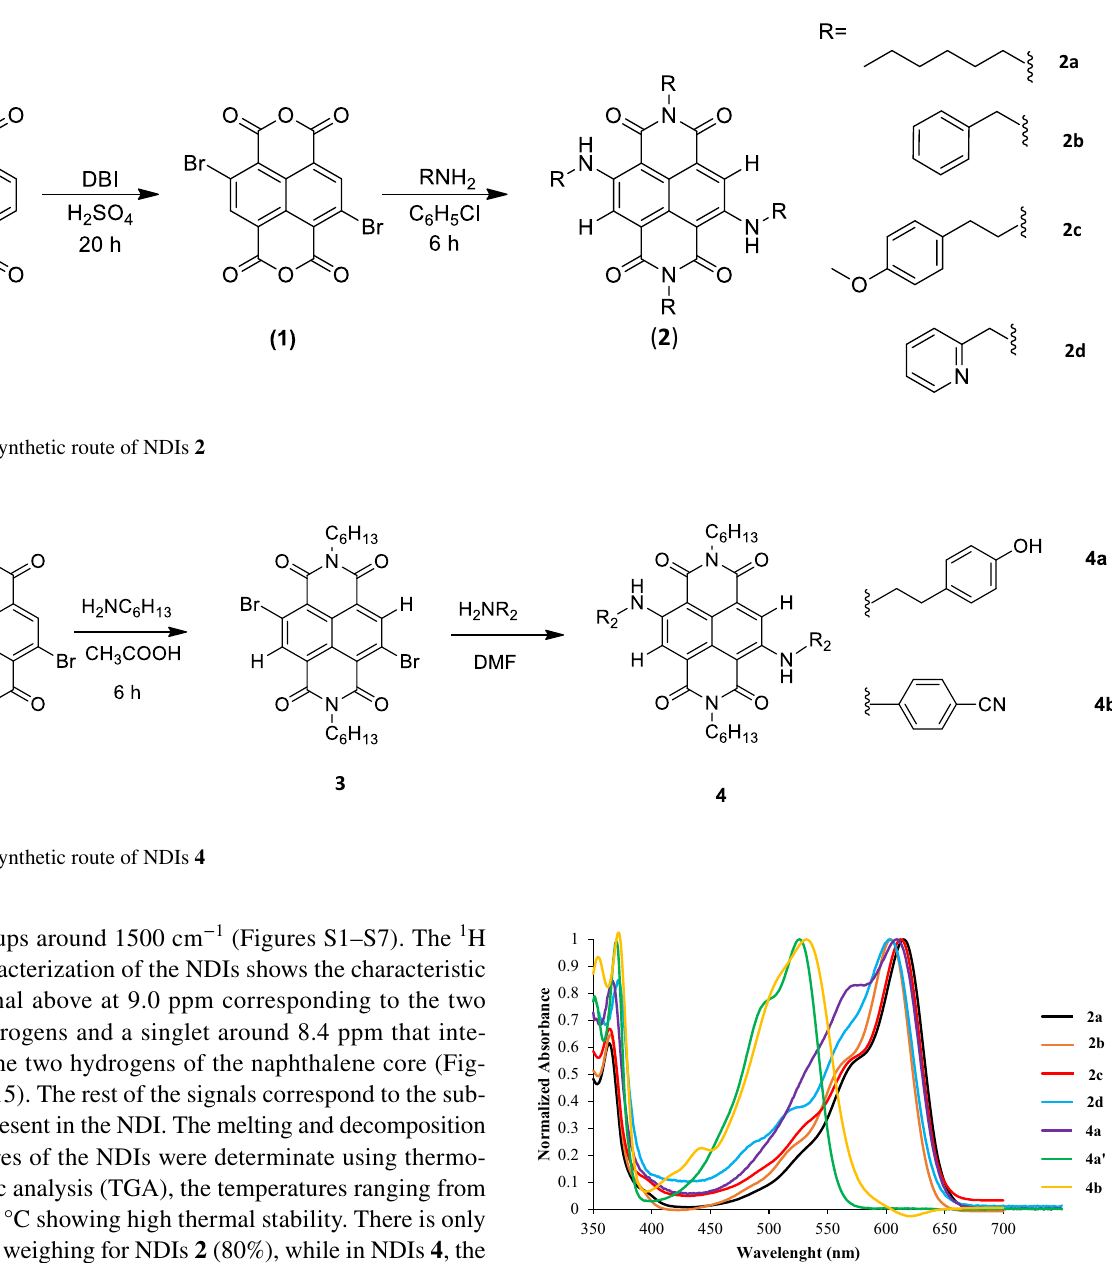
Fig. 1 Normalized absorption bands of the NDIs 2 and 4 in DCM at 5 × 10 –5